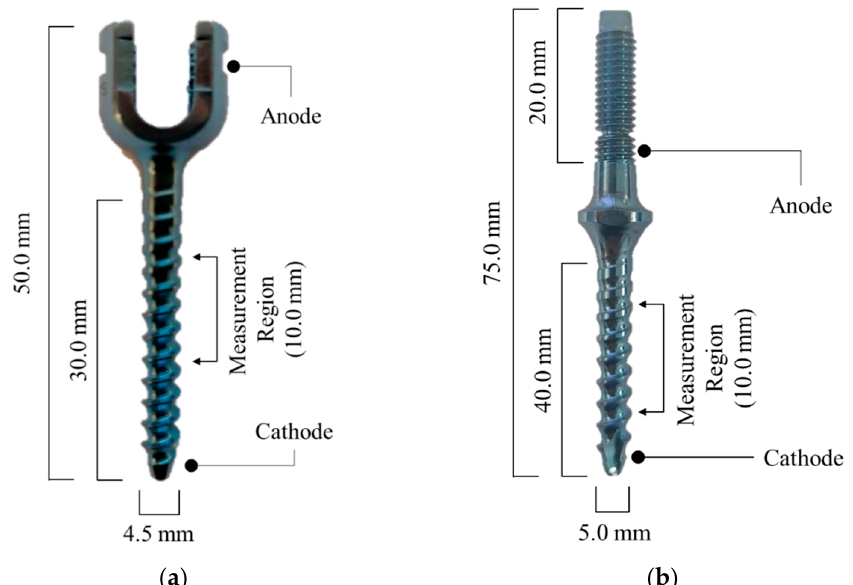
Figure 1. Representation of the ( a ) Spinelock and ( b ) Spinecall pedicle screws specimens used in this study, their physical dimensions and relevant current application and measuring points.